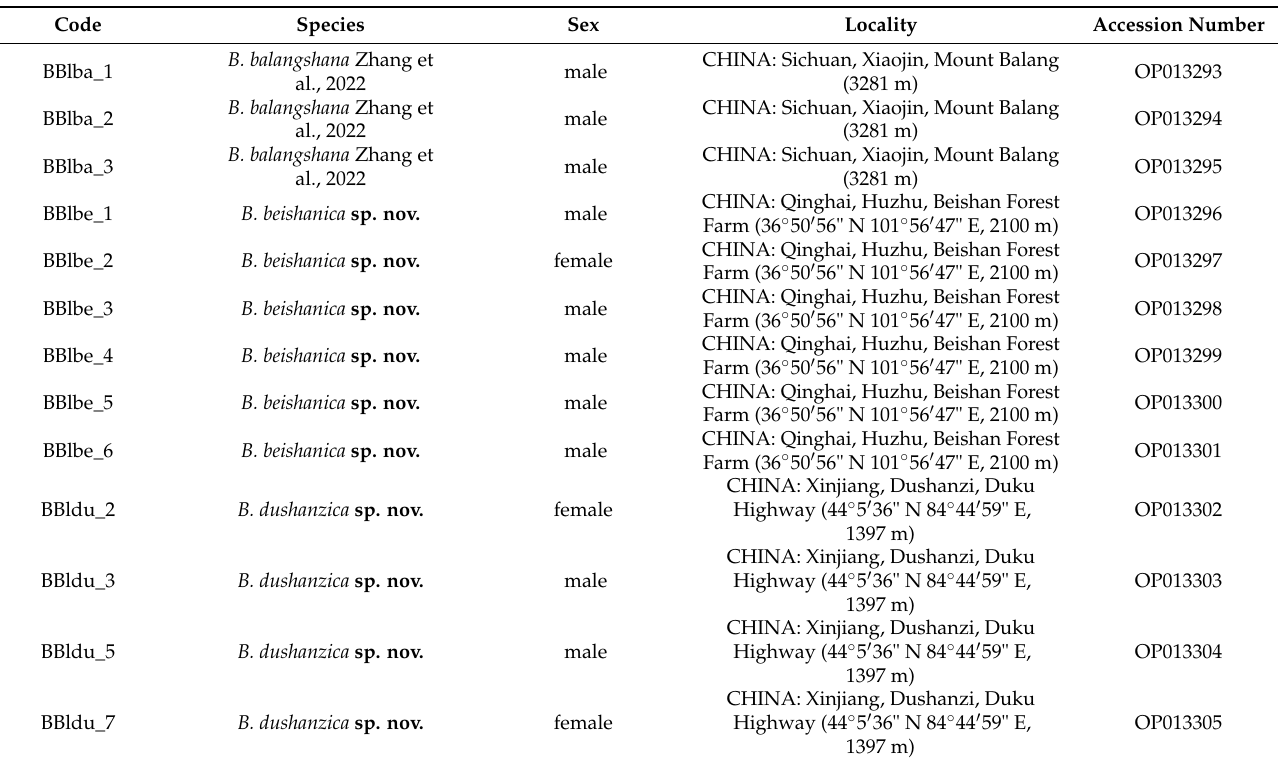
Table 1. Information of Blepharicera specimens sequenced in this study with GenBank accession numbers of mt COI